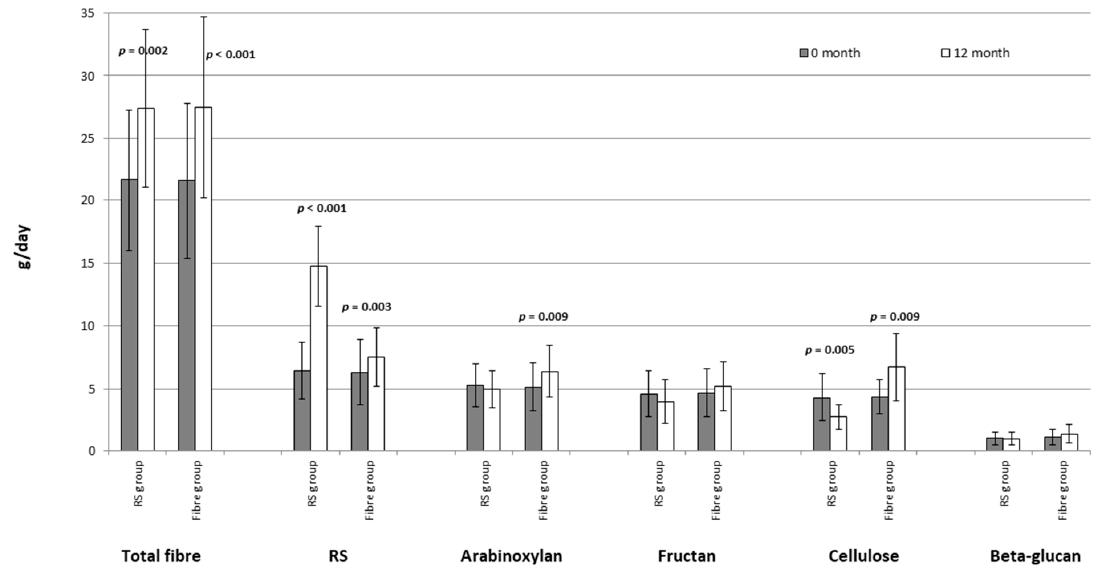
Figure 2. Fibre and fibre fractions intake at the beginning and after 12 months of lifestyle intervention in the resistant starch (RS) and the Fibre group; (Means ± SD; paired t -tests).